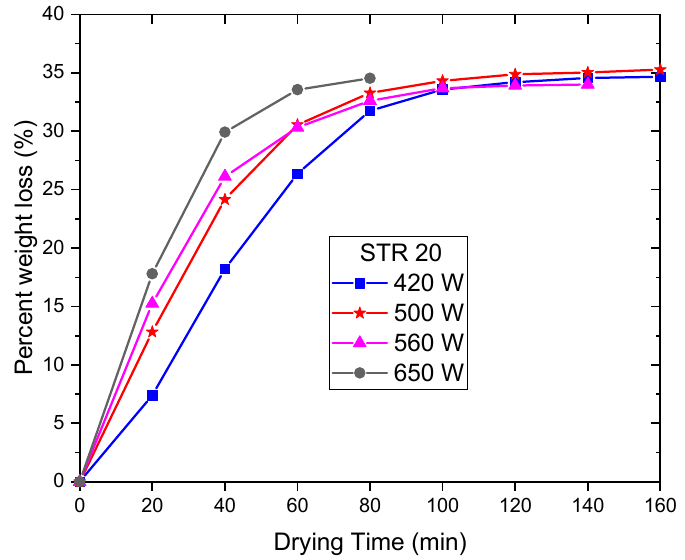
Figure 9. The relationship between drying times and percent weight loss of the STR20 samples when different microwave power levels were applied. different microwave power levels were